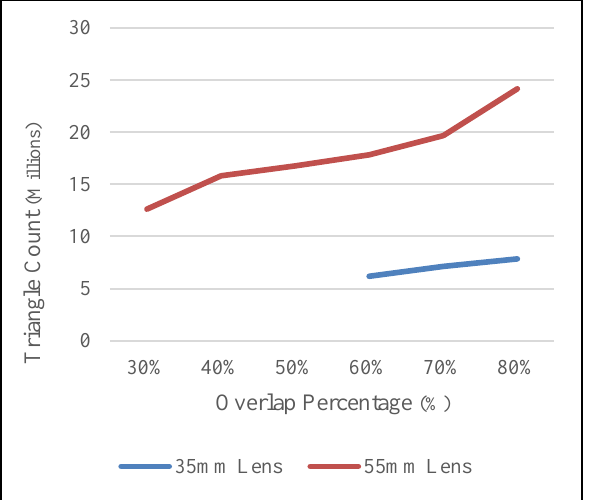
Figure 9. Projection Errors per each overlap value.